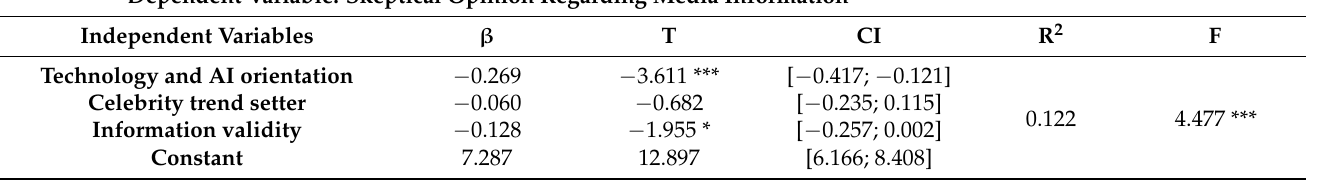
Table 5. Regression model for cluster